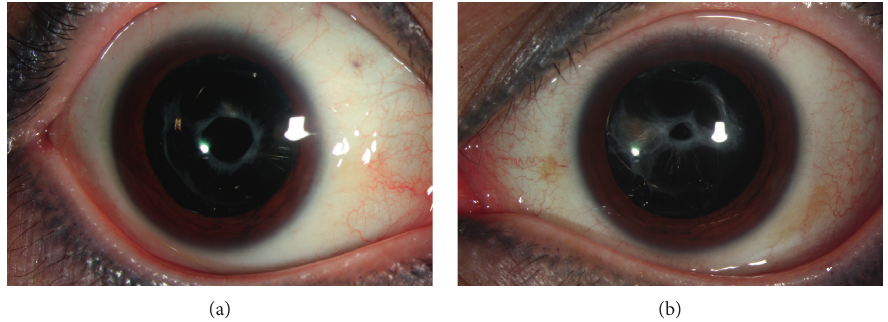
Figure 3: Example of a patient occurred bilateral anterior capsular opacification (ACO) or anterior capsular contraction following phacoemulsification with hydrophilic IOLs. (a) ACO occurred in the right eyes after 2.5 months. (b) ACO occurred in the left eyes after 3